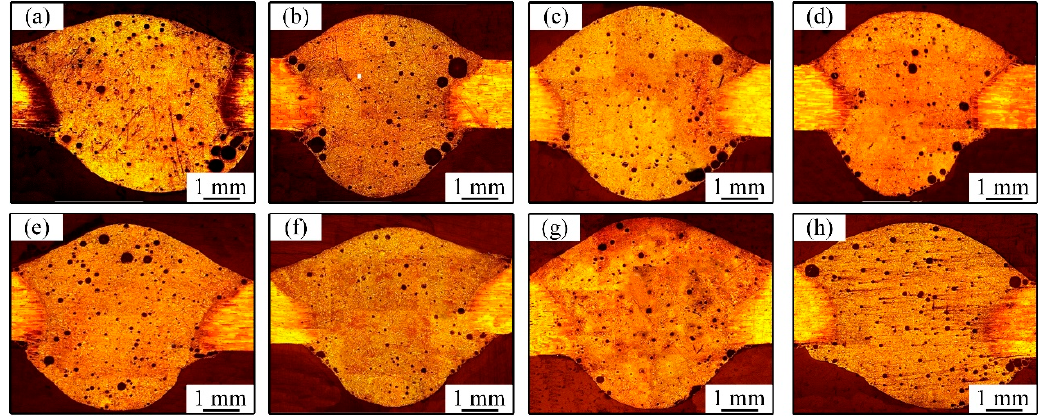
Figure 4. ( a – h ) Distribution of pores in the welded joints welded by ( a ) AC CMT and ( b ) AC CMT coupled current at frequency of 20 kHz, ( c ) 30 kHz, ( d ) 40 kHz, ( e ) 50 kHz, ( f ) 60 kHz, ( g ) 70 kHz, and ( h ) 80 kHz, respectively.